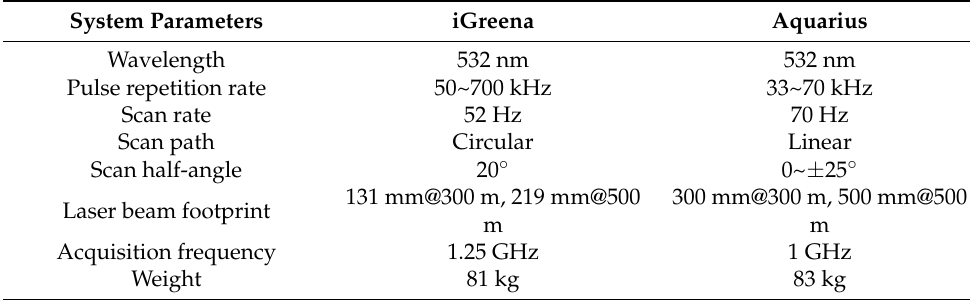
Table 3. Experimental system parameters.